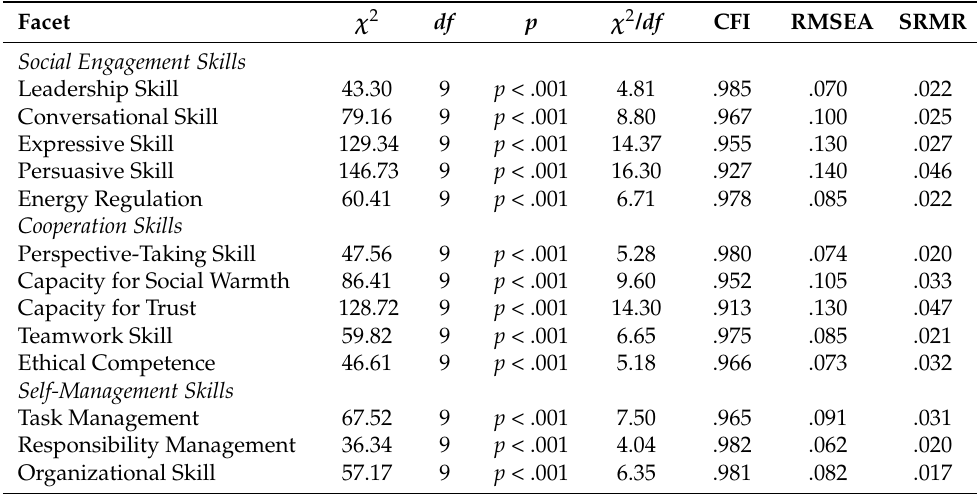
Table 3. Model fits of the 32 single-factor CFA models for BESSI-G v0.2 (Study